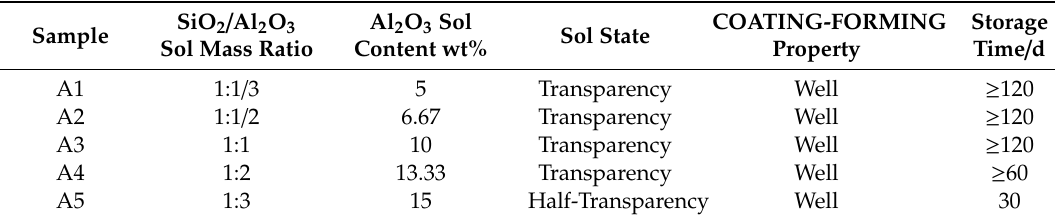
Table 4. SiO 2 / Al 2 O 3 sol solution with di ff erent mass